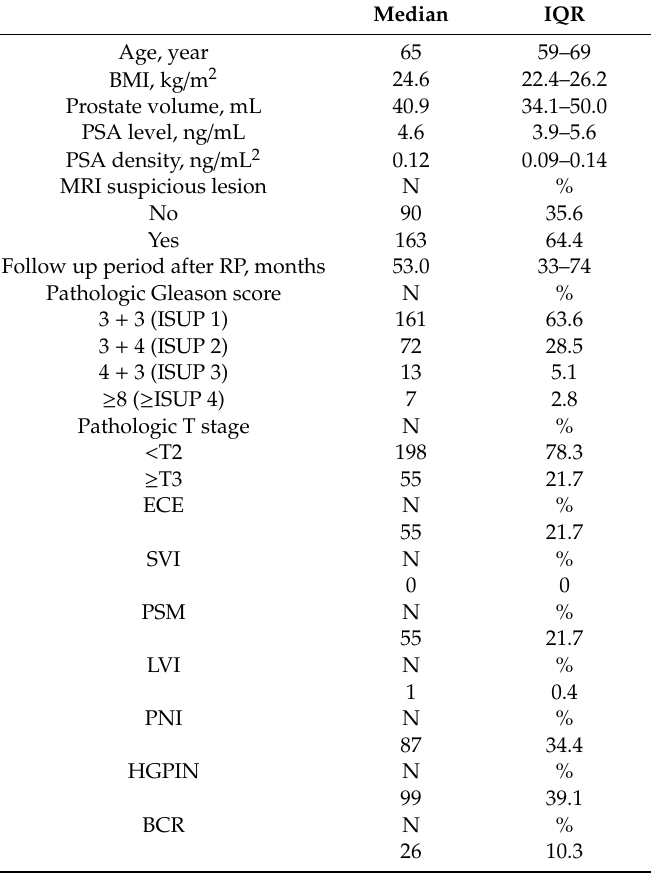
Table 1. Baseline patient characteristics.